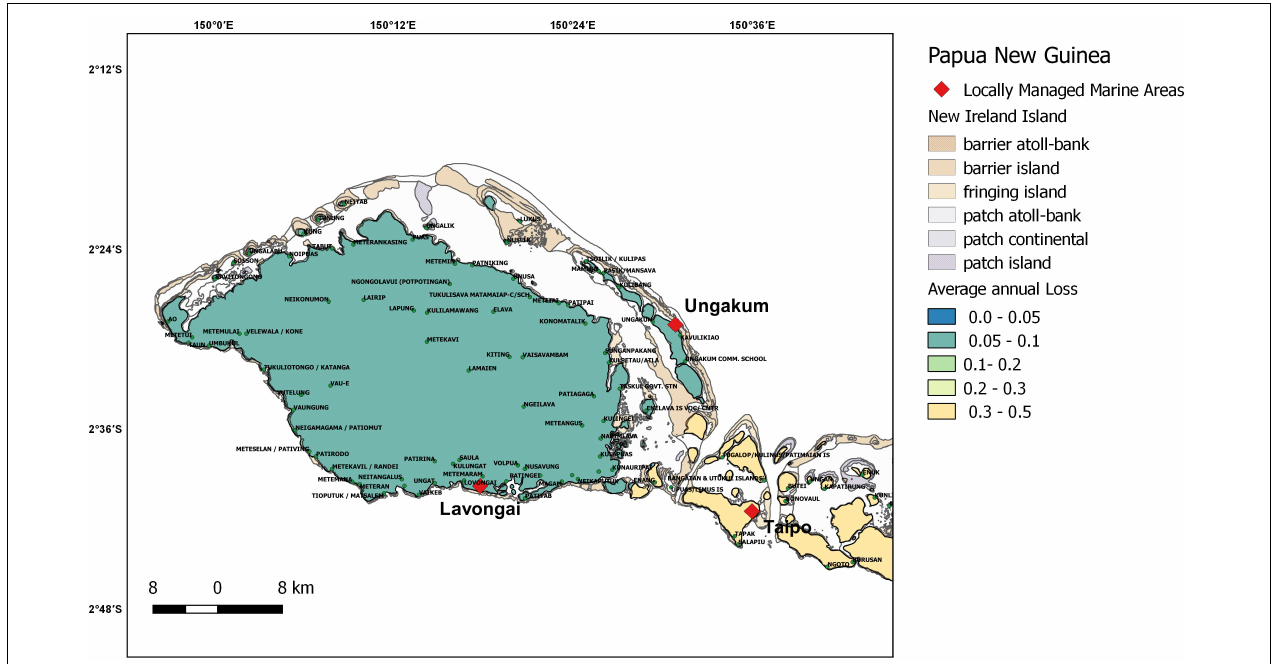
FIGURE 2 | This map illustrates the capacities of Geographic Information System Mapping (GIS) to enable the risk assessment of an area, in western New Ireland Island, PNG, located in the Bismarck Sea (Tilot et al., in progress). The area is assessed as socio-economically and environmentally vulnerable. The geo-positioning of different layers of information corroborates the location of small indigenous villages, the sites of Locally Managed Marine Areas (LMMAs), the types of coral reefs habitats and bathymetry and the economic impact assessment due to natural hazards through an Average Annual Loss (Andréfouët et al., 2006; PacGeo, 2020). Map designed with Geospatial data sets obtained from open access geospatial data repositories from the Millennium Coral Reef Mapping Project,(Data from a global coral reef database that was released by the United Nations Environmental Program World Conservation Monitoring Center (UNEP-WCMC). It was created from multiple sources, including USF’s Millennium Coral Reef Mapping Project Seascape database and merged together by UNEP-WCMC and the WorldFish Center in collaboration with the World Resources Institute (WRI) and The Nature Conservancy (TNC).) the Institut de Recherche pour le Développement (IRD/Center de Nouméa), the geospatial data repository for the Pacific Region (PacGeo, 2020), the online GIS databases of the World Wildlife Fund (WWF) and the Coral Triangle